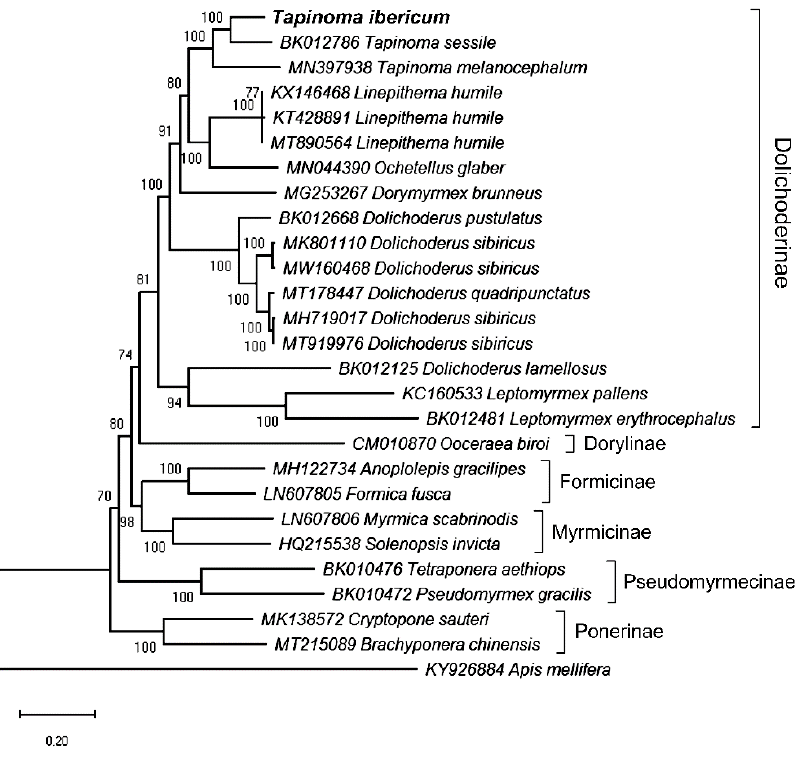
Figure 6. Phylogenetic relationships based on the Maximum Likelihood (ML) analysis. Bootstrap values above 70 are indicated next to the branches. The tree was rooted using Apis mellifera as out-